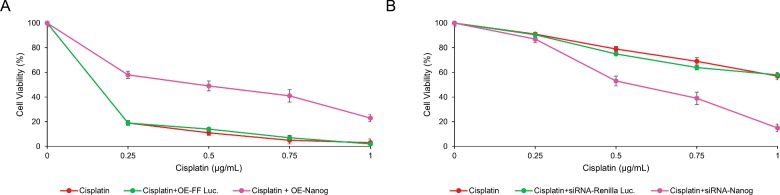
NANOG modulation changes susceptibility to cisplatin treatment(A) Moody cells were either untransfected or transiently transfected with firefly luciferase or NANOG for 12 h. (B) SKOV-3 cells were either untransfected or transiently transfected with shRNA targeting Renilla luciferase or NANOG construct for 12 h. The cells were then treated with indicated doses of cisplatin for 72 h. Cell viability was assessed by the MTT assay.